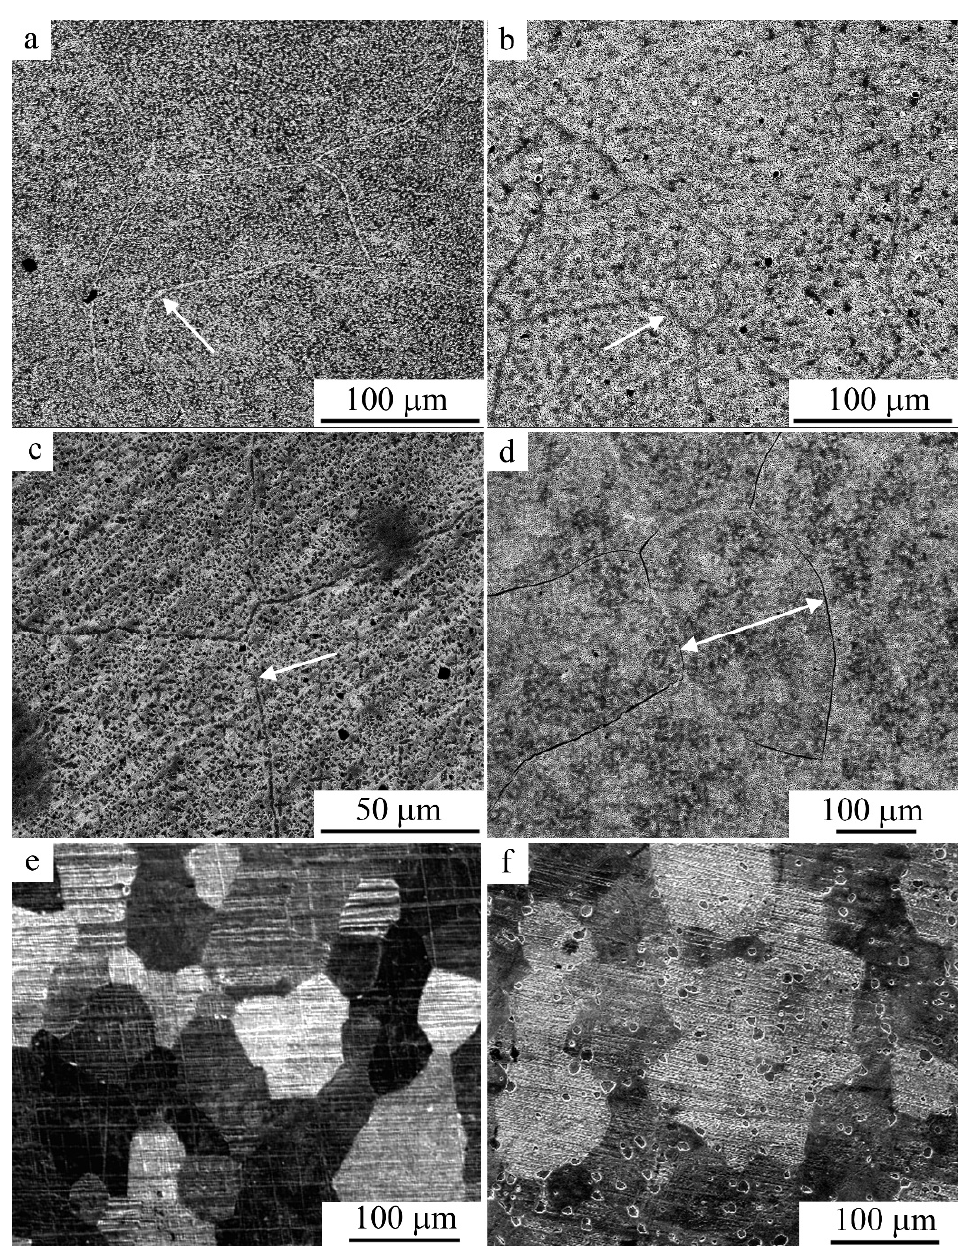
Figure 6. ( a – d ) Secondary electron SEM images and ( e , f ) OM images of the FG structure in the Cu-14Al-4Ni alloy after the compression tests at ( a – c ) 673 K (( a )— v = 5, ( b )— v = 1, ( c )— v = 0.5 mm/min), ( d ) 873 K ( v = 5 mm/min), ( e ) 973 K ( v = 1 mm/min), and ( f ) 1073 K ( v = 1 mm/min).